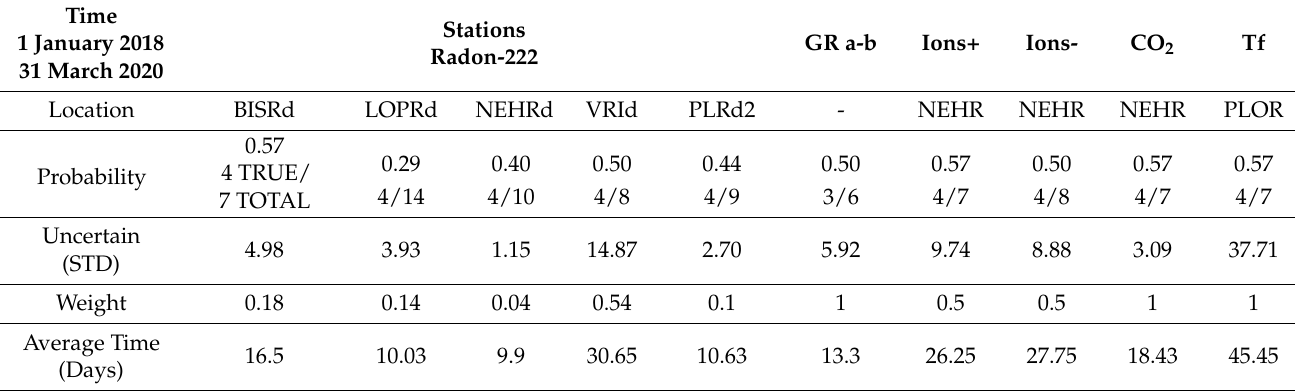
Table 2. Probability of true/false detections, uncertain and average of times between the detection of radon, Guten- berg Richter a-b, ions, CO 2 , temperature in